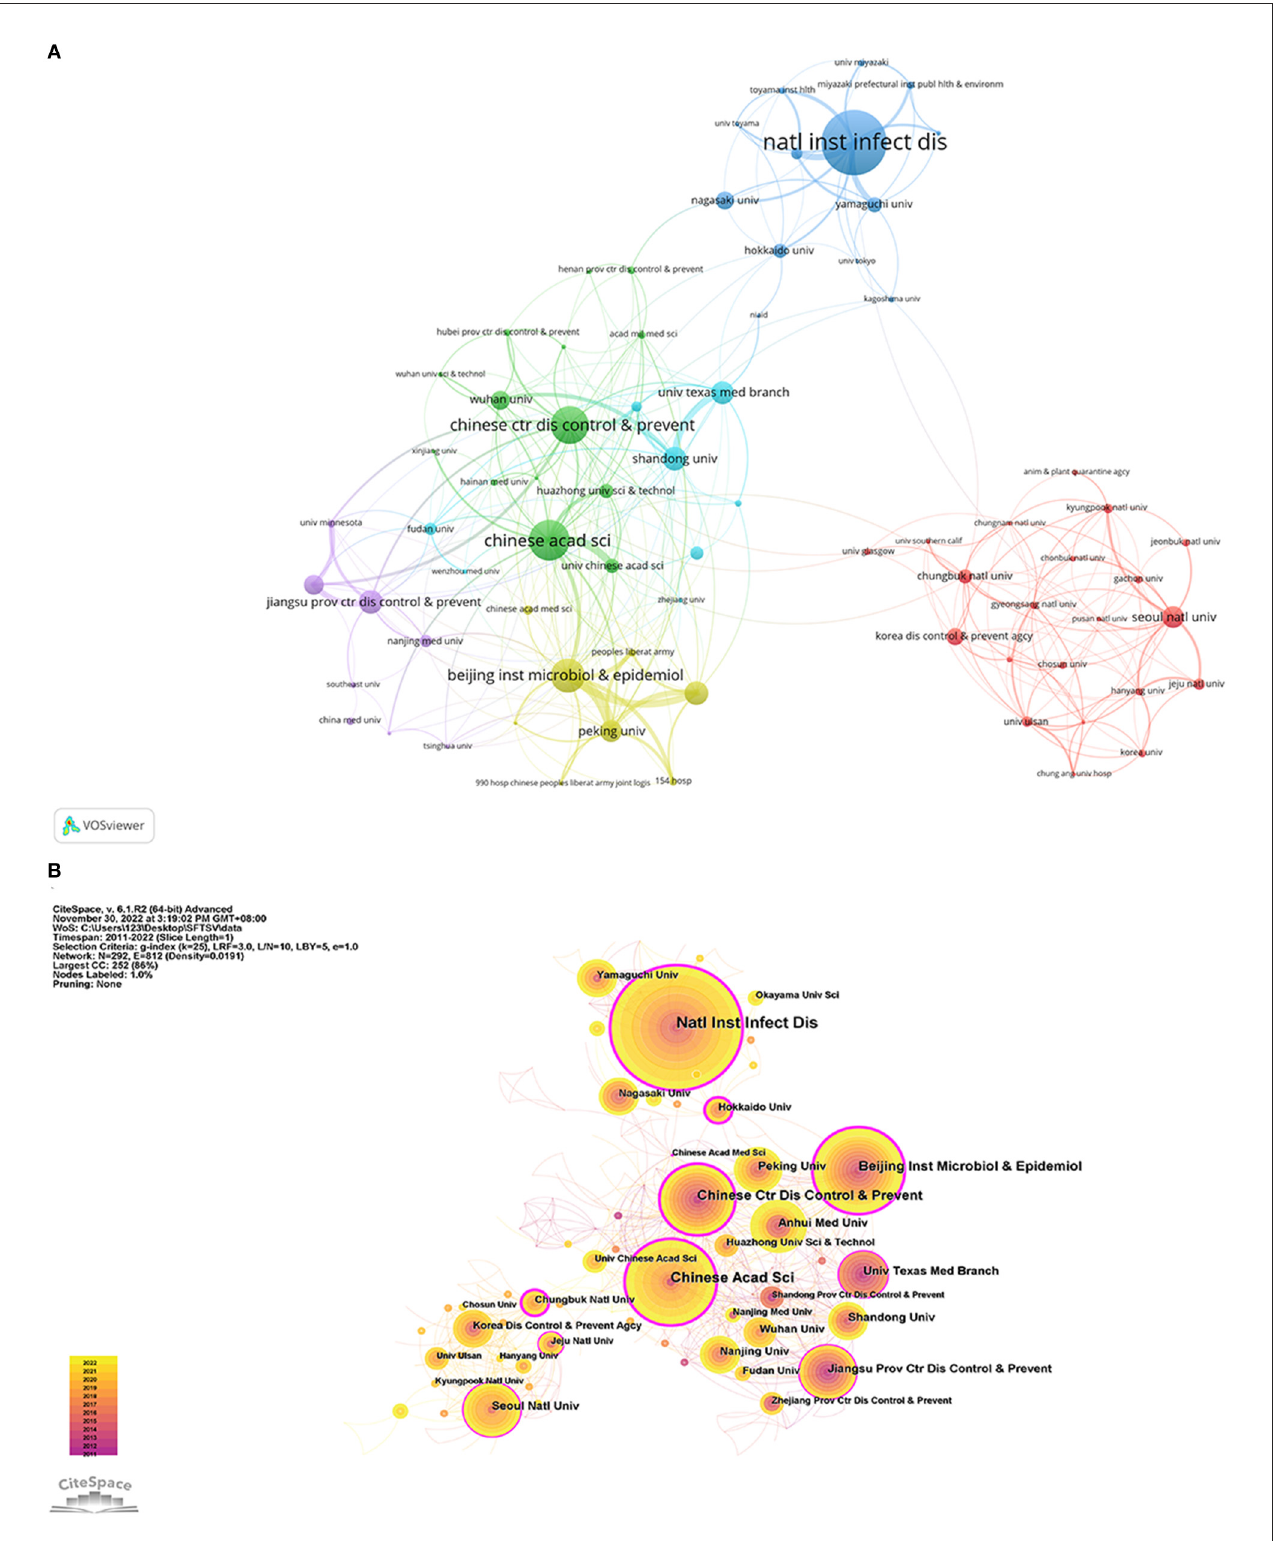
FIGURE4 Visualization map of institution on SFTSV. (A) Cooperation map of 72 institutions with the number of publications no less than 5 times. (B) Centrality cooperation map of institutions.